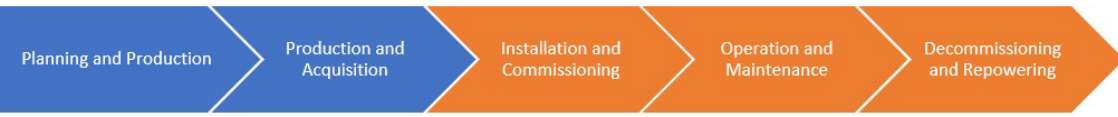
Figure 1. Stages in the development of a wind farm.